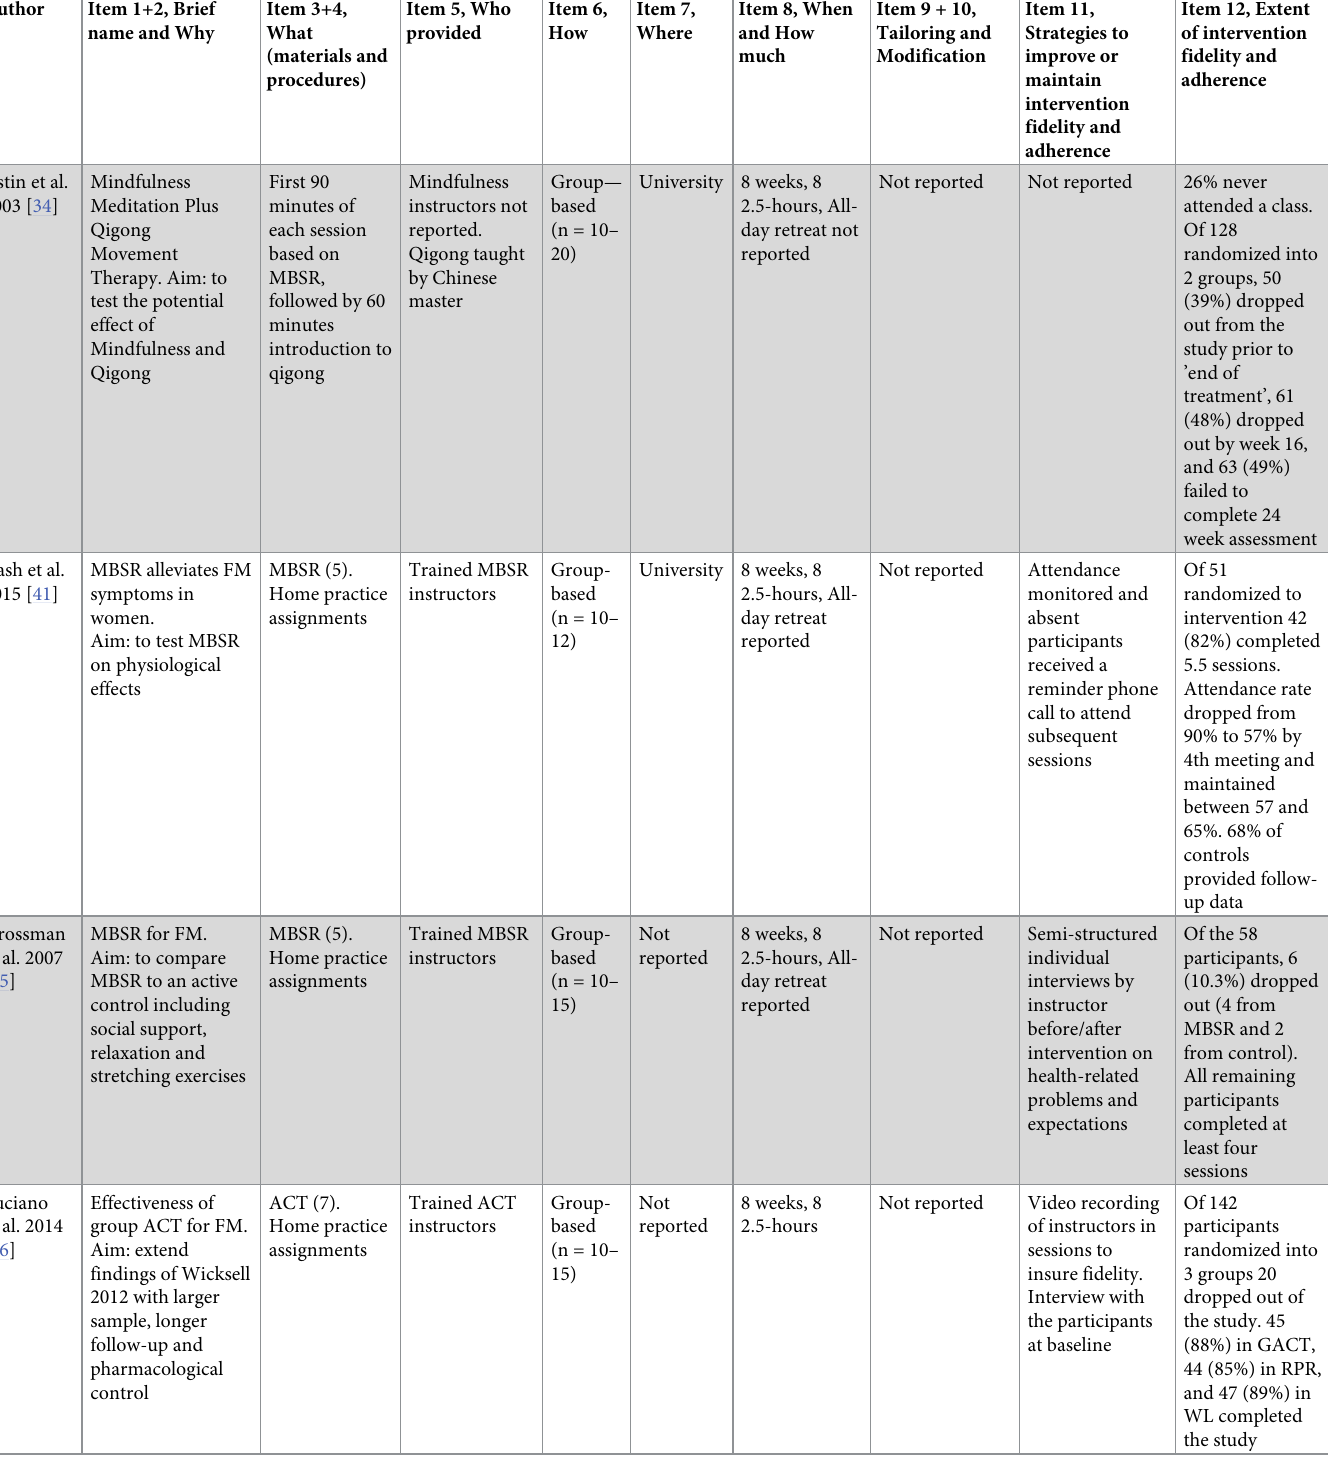
Table 2. TIDieR-checklist, template for intervention description and replication. Description of content and delivery